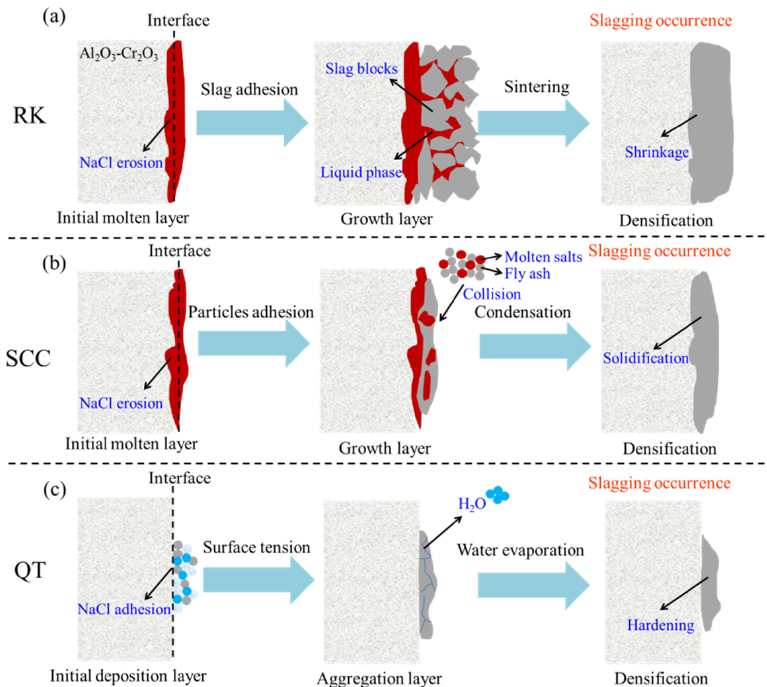
Figure 8. Formation mechanisms of slagging rings during hazardous waste incineration: ( a ) second half of the rotary kiln (RK); ( b ) exit flue of the secondary combustion chamber (SCC); and ( c ) wall of the quench tower (QT).